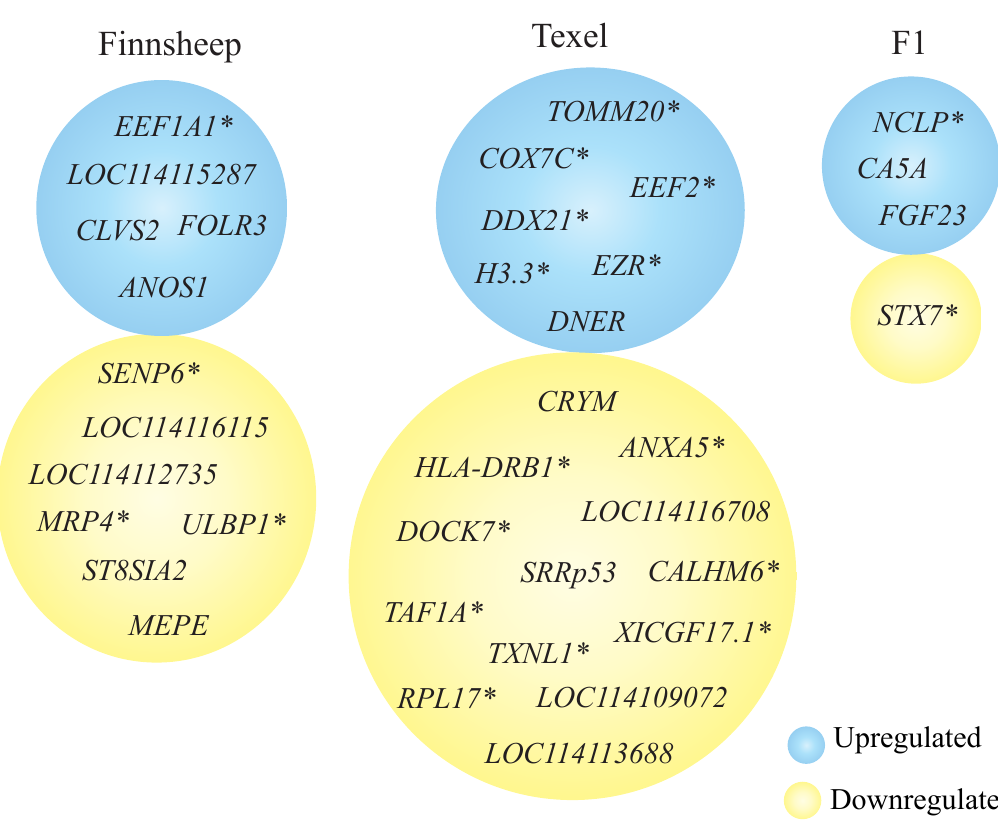
Figure 4. List of uniquely di ff erentially expressed genes in Finnsheep, Texel and F1. Gene names that were not part of Rambouillet reference transcriptome are marked with an asterisk (*) while gene IDs starting with LOC are “uncharacterized ncRNA”.